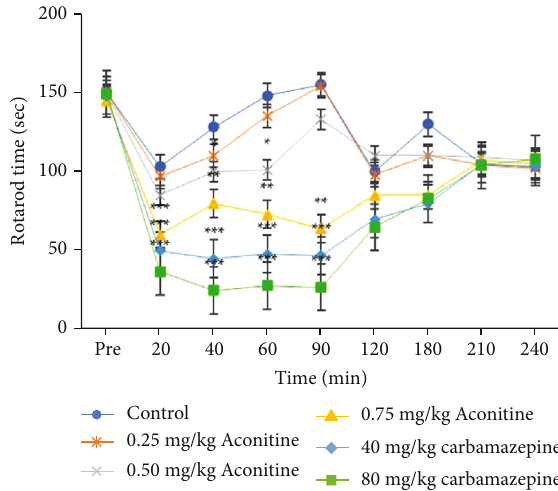
Figure 3: E ff ects of test samples on motor coordination in rotarod